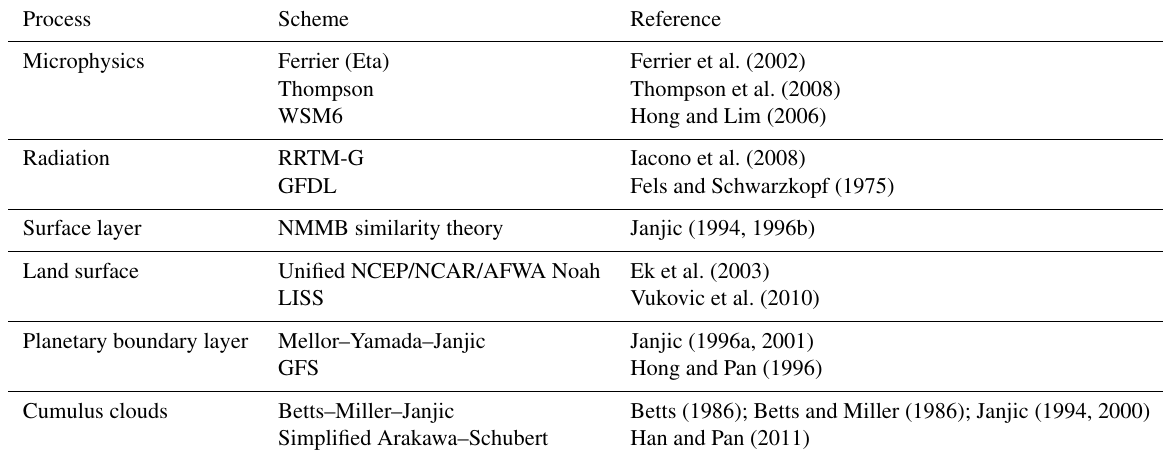
Table 1. Available physics schemes in